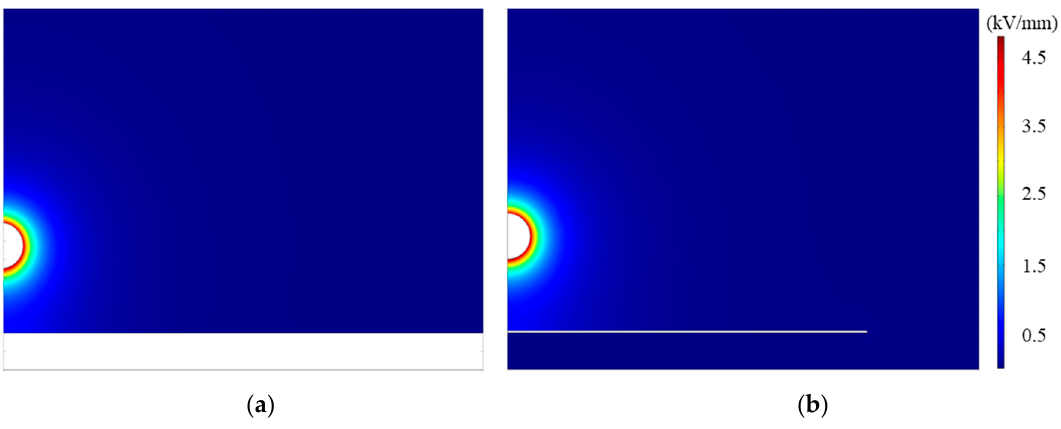
Figure 1. Electric field analysis results (( a ) Infinite grounded electrode, ( b ) Finite grounded electrode). Table 1. Electric field analysis results for determining the electrode configuration.